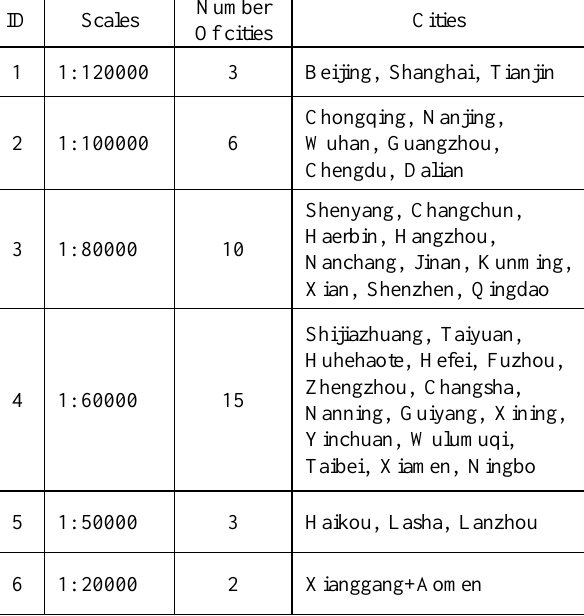
Table 1. scale classification of city